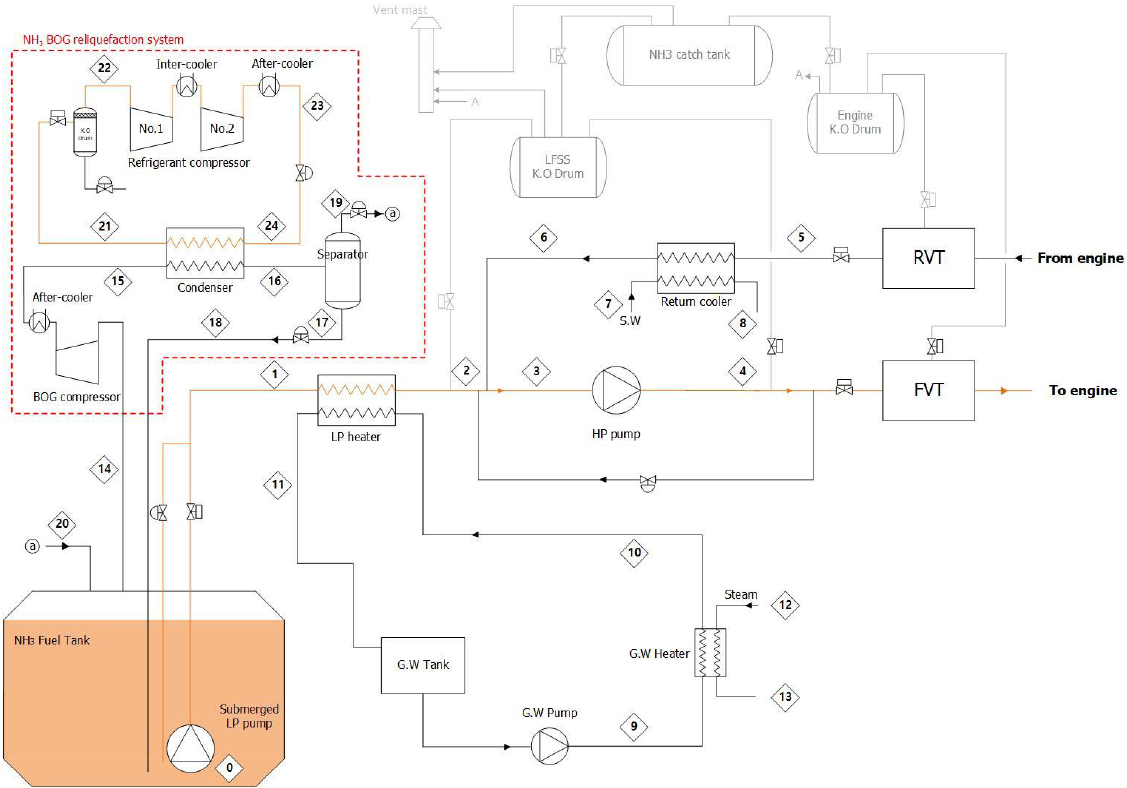
Figure 2. Process flow diagram for NH 3 re-liquefaction system with FSS.